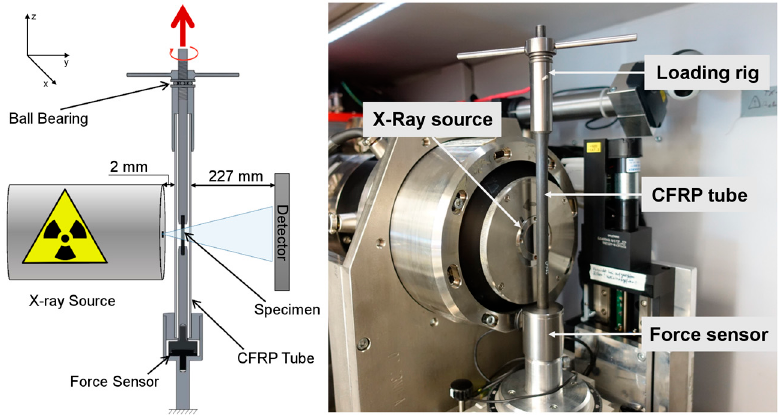
Figure 3. Sketch ( left ) and picture ( right ) of the in-situ CT experiment setup. By turning the wing nut at the top of the loading rig, the inner rod is pulled upwards and causes tensile stress in the specimen. To maximize magnification, the distance between X-Ray source and loading rig wall is at a minimum of 2 mm (sketch not to scale).